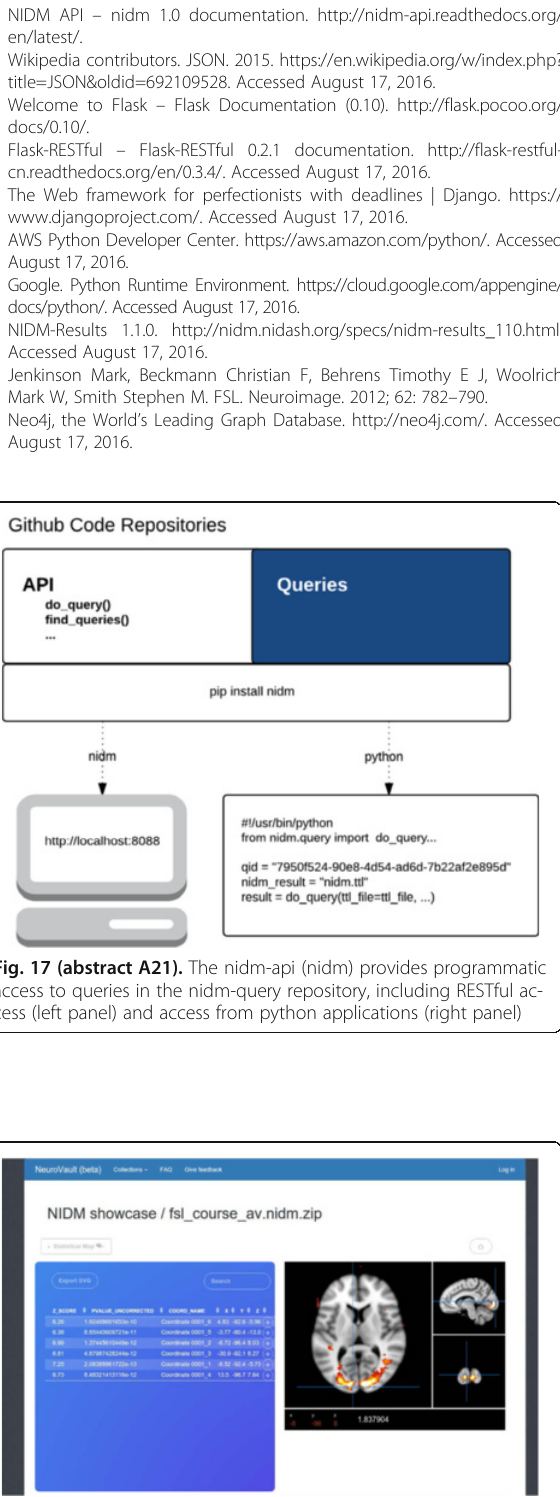
Fig. 18 (abstract A21). The nidm-viewer in the NeuroVault database queries NIDM Results objects to generate an interactive table and statistical brain